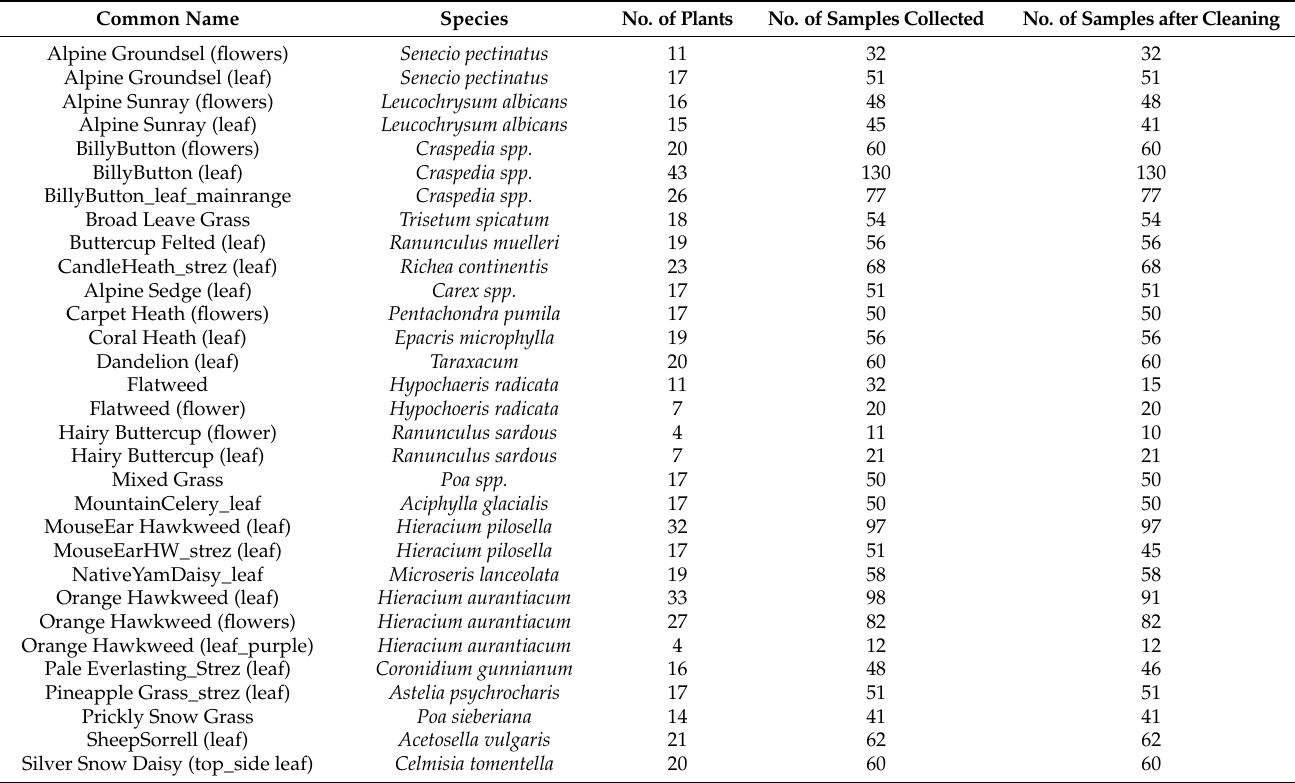
Table 2. Summary of the 30 species sampled using leaf-clip in the second field survey conducted in January and February 2018. The total number of plants and total number of samples before and after the removal of outliers are listed. Common